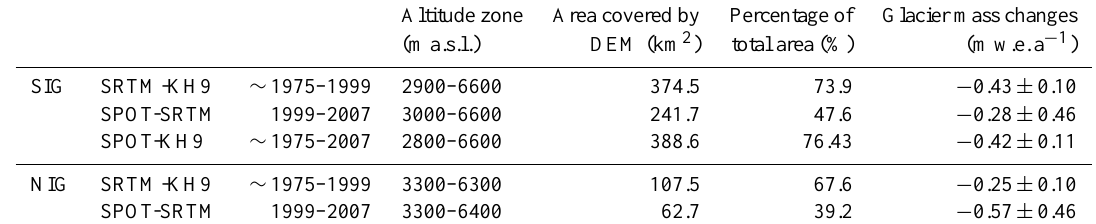
Table 4. Glacier mass changes based on area-averaged d h/ d t for period ∼ 1975–2007.